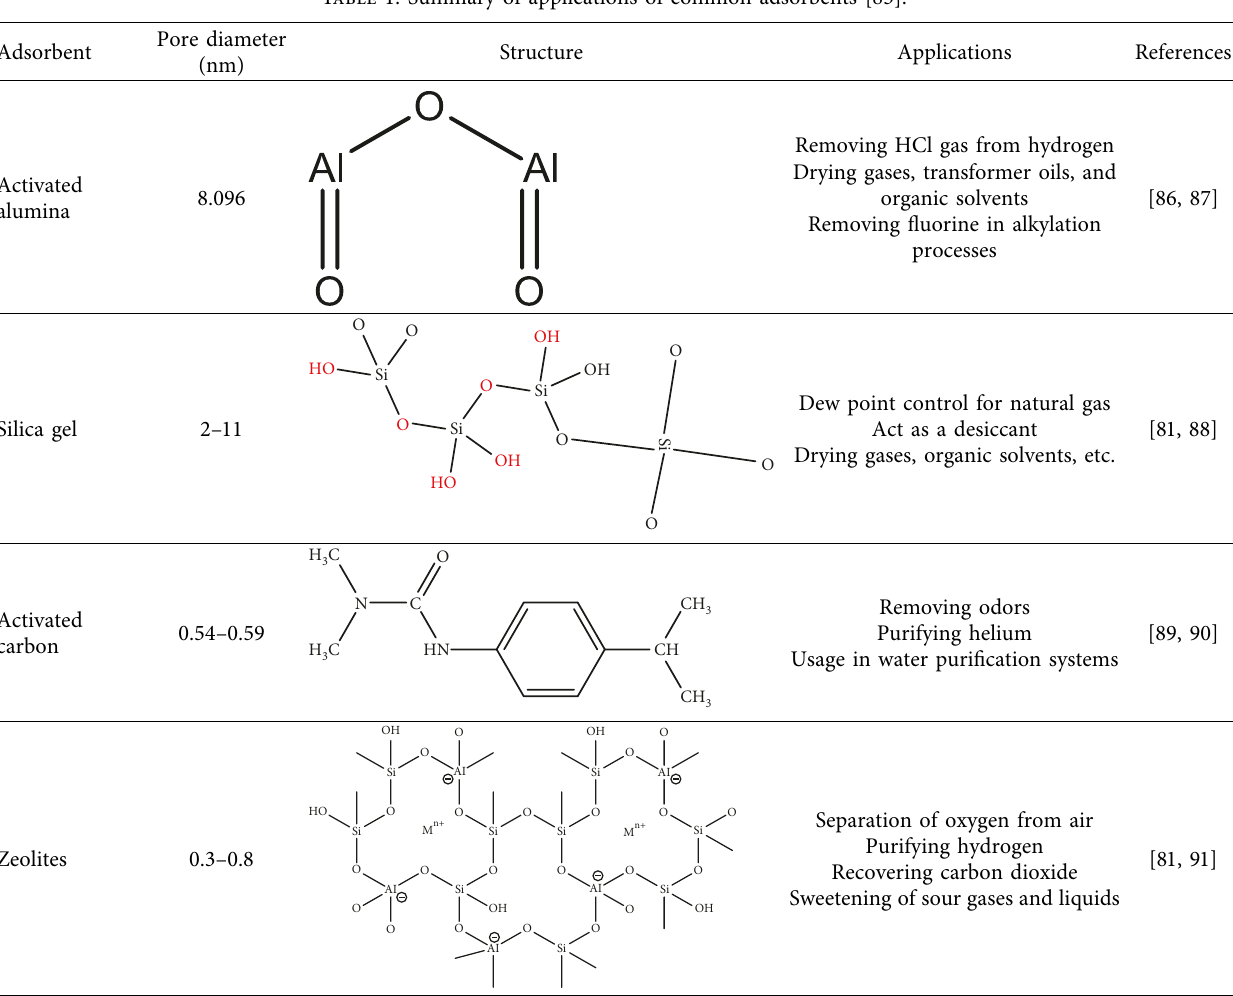
Table 1: Summary of applications of common adsorbents